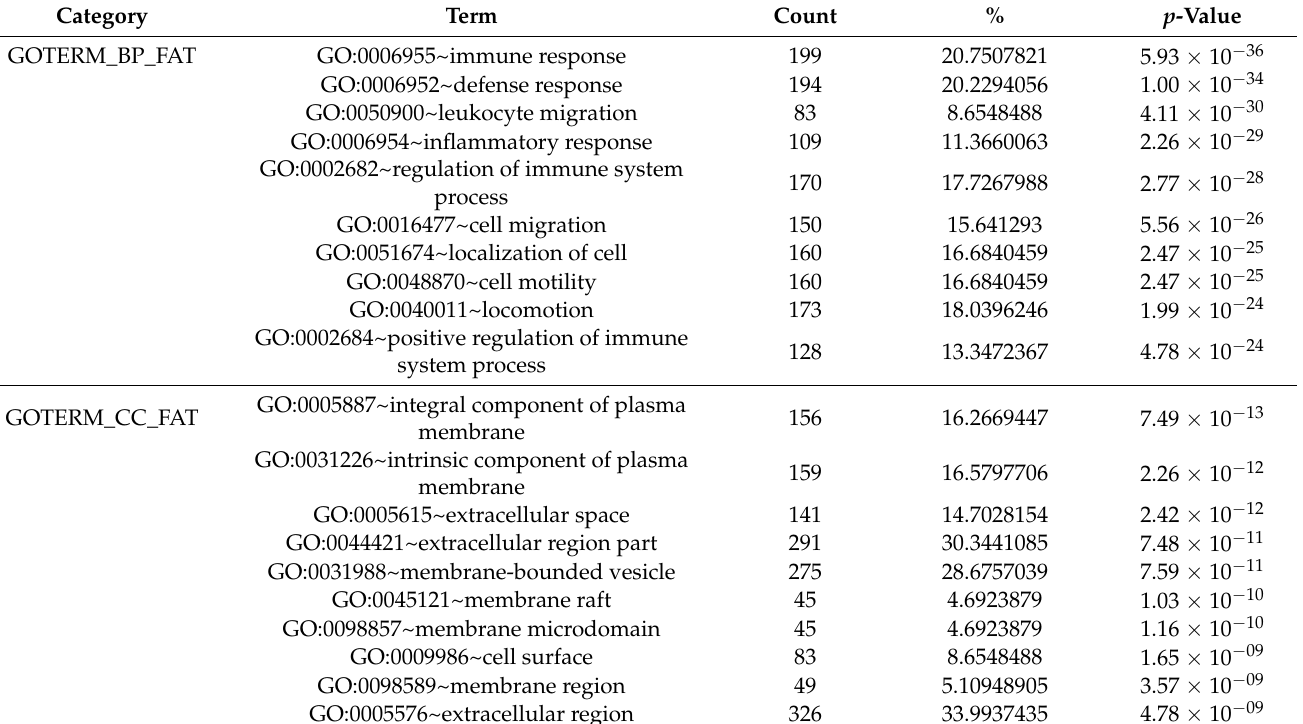
Table 2. The GO and KEGG pathway enrichments of the 61 common hub genes in the turquoise module.